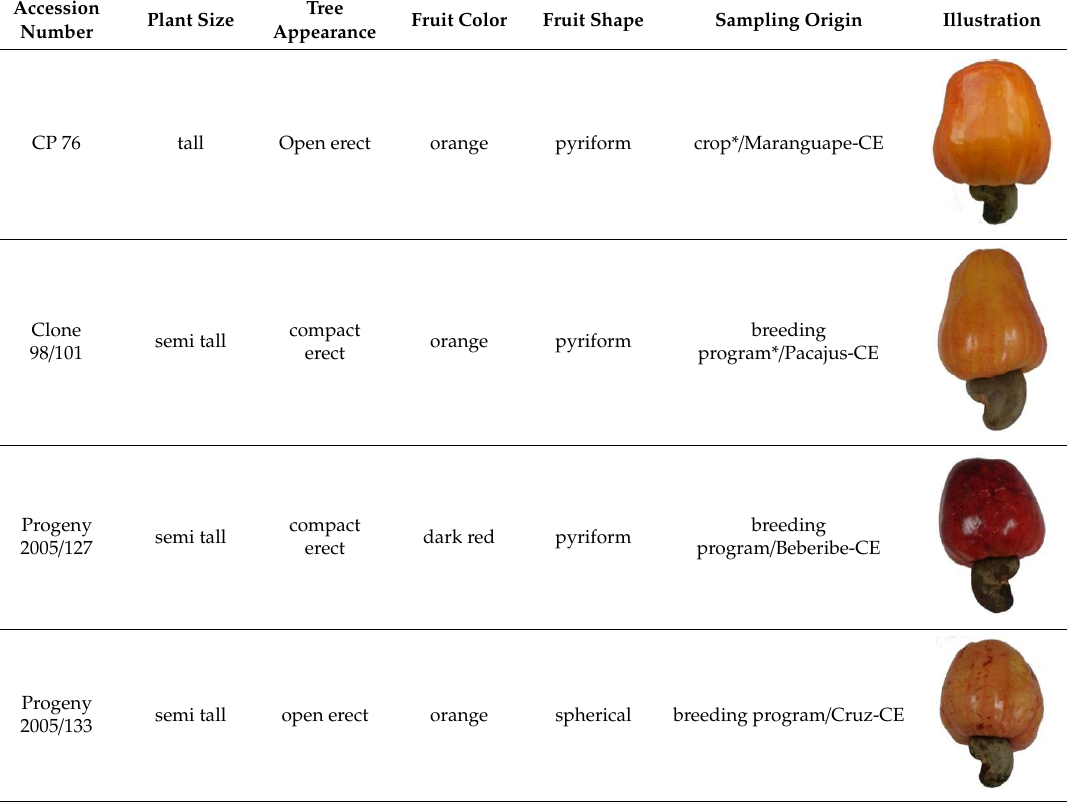
Table 3. Illustration of the cashew genotypes associated with the accession number and morphoagronomic characteristics: plant size, tree appearance, fruits color and shape, and origin (county-state).